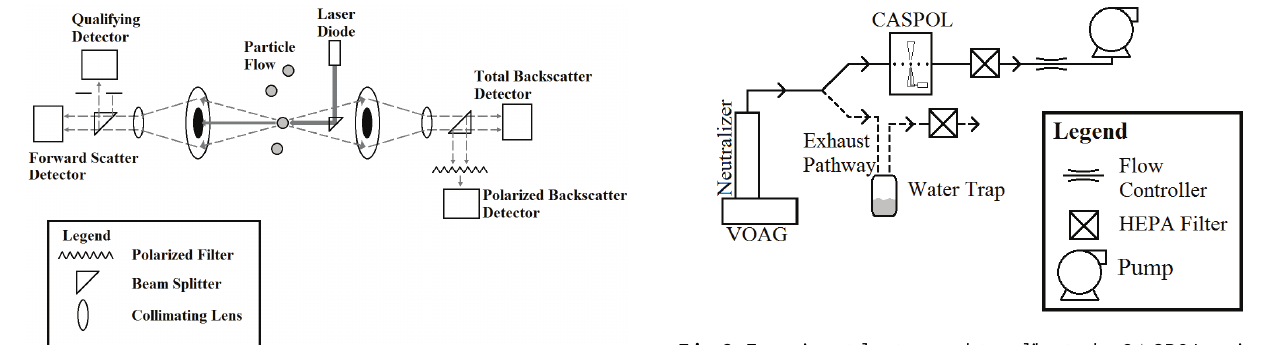
Fig. 2. Experimental setup used to calibrate the CASPOL using a TSI Vibrating Orifice Aerosol Generator